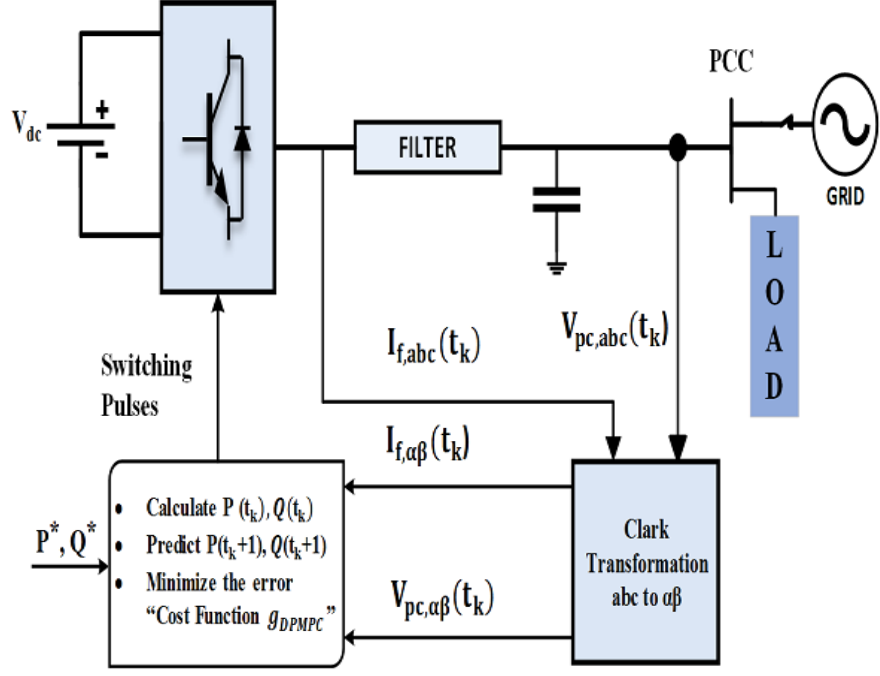
Figure 4. Block diagram of FCS − DPMPC.